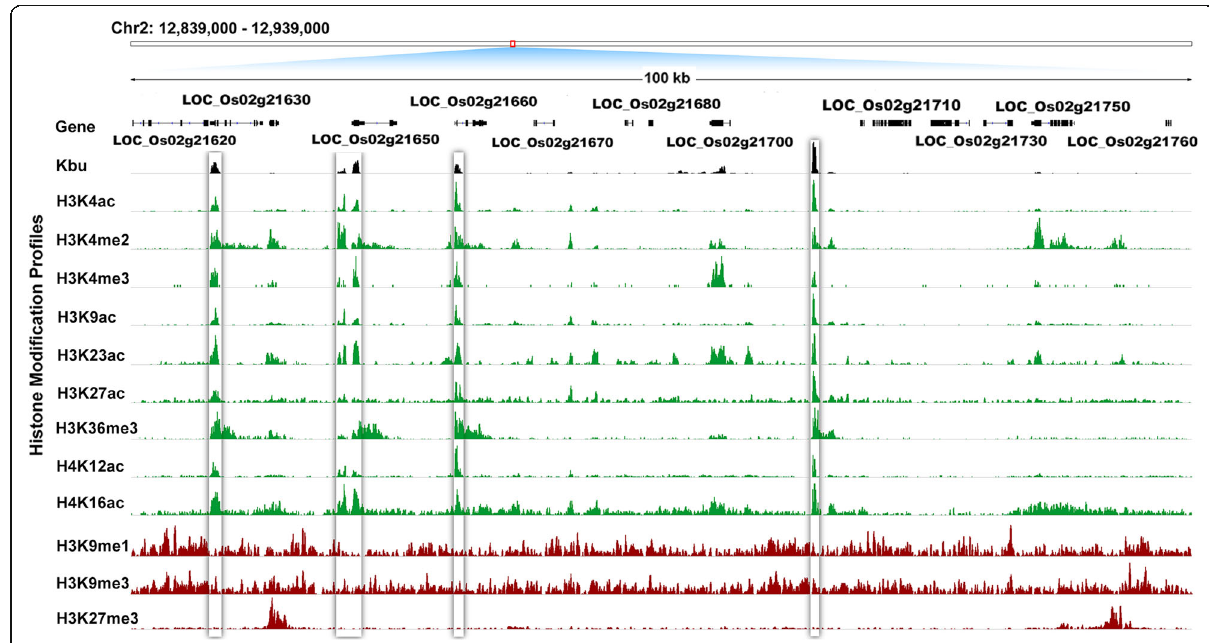
Fig. 3 Gene transcription in the rice genome and the genomic distribution of histone Kbu and other modifications. Visualization of the Kbu sites and 12 other histone modifications against 10 gene loci in a 100,000 base pair region on Chr2:12,839,000 –